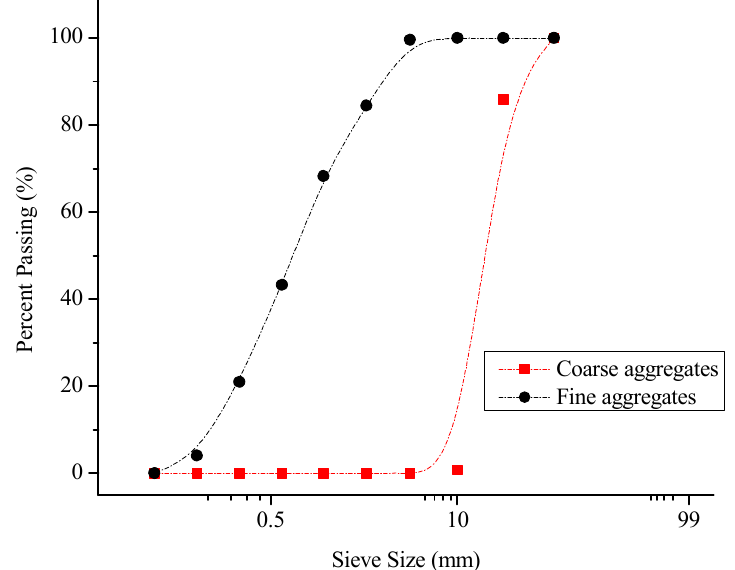
Figure 1. Gradation of the fine and coarse aggregates. Table 2. Properties of the aggregates.